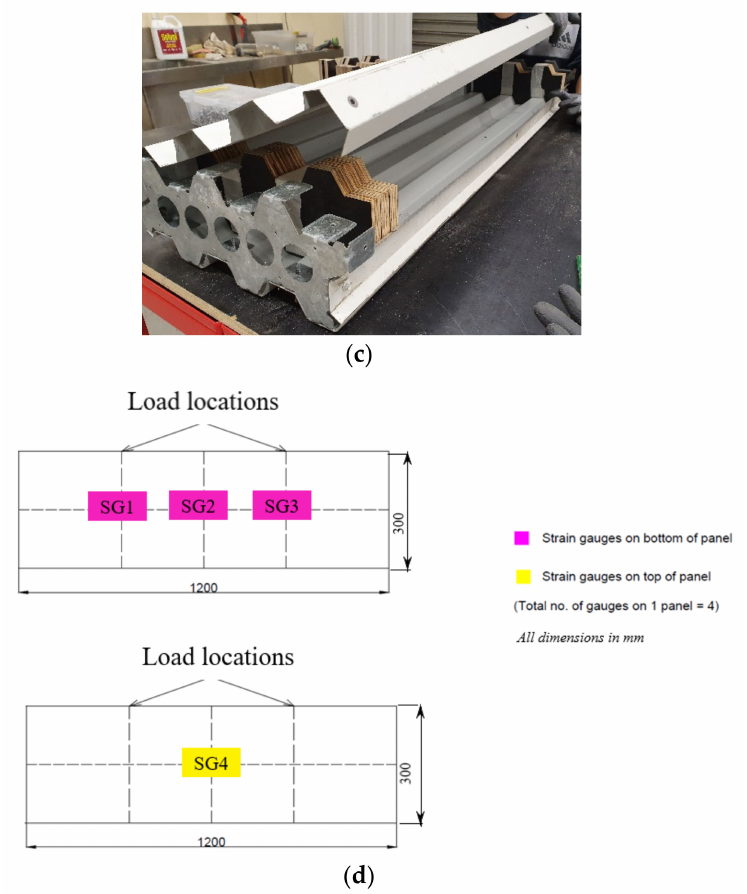
Figure 3. ( a ) Test set-up for panels. ( b ) Test arrangement of the single-cell panel. ( c ) Open panel with timber blocks inserted over end support regions. ( d ) Position of strain